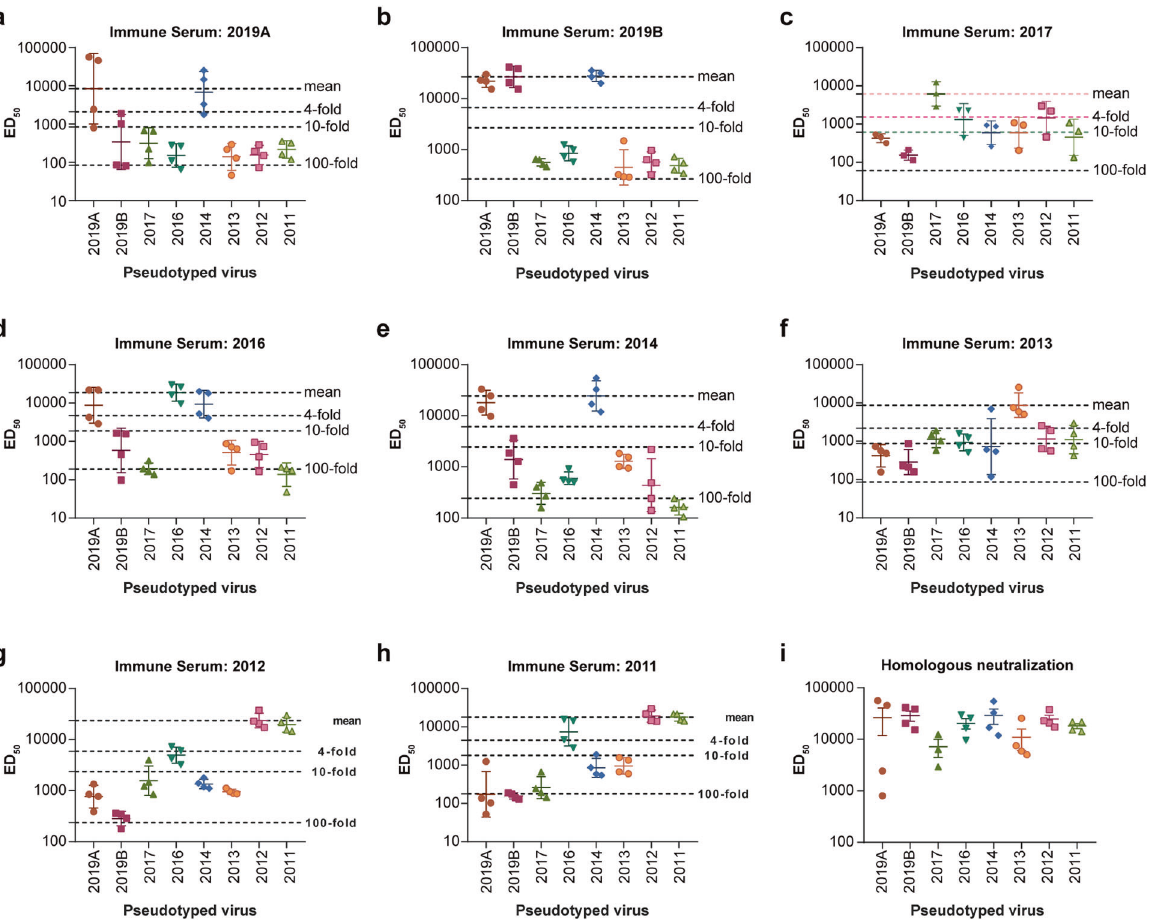
Fig. 5 Neutralization activity of in fl uenza HA plasmid-immunized sera against H3N2 vaccine strains. Guinea pigs were immunized with in fl uenza HA plasmids of the vaccine strains of 2011 – 2019. Sera were collected for neutralization activity testing against pseudotyped viruses of the H3N2 vaccine strains from 2011 – 2019. Mean ED 50 from three repeated experiments are shown as dot plots. Dashed lines indicate 4-, 10-, and 100-fold differences compared with the corresponding vaccine strain. The homologous neutralization activity is compared in the last graph. HA haemagglutinin, H3N2 haemagglutinin 3 neuraminidase 2, ED 50 50% effective